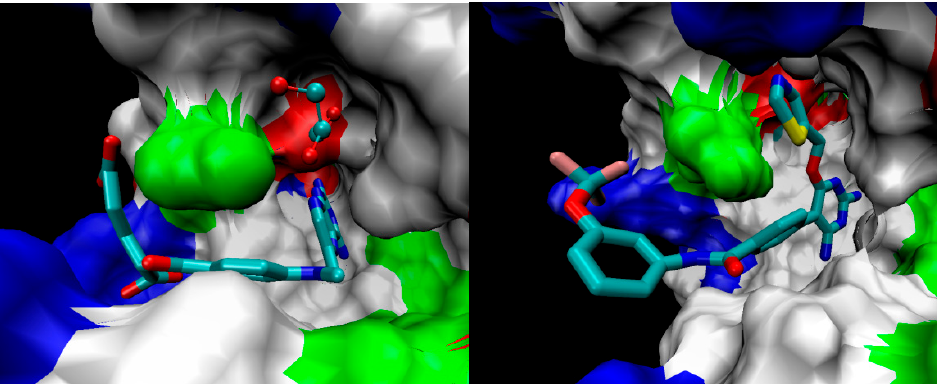
Figure 2. Left: the binding sites of methotrexate (MTX) and glycerol (GOL) in mt -DHFR, in which MTX is represented as a sticks model, GOL as a ball-stick model, and protein as a molecular surface; Right: the designed molecule is predicted to be able to occupy the GOL binding site, in which the molecule is represented as sticks and protein as a molecular surface.